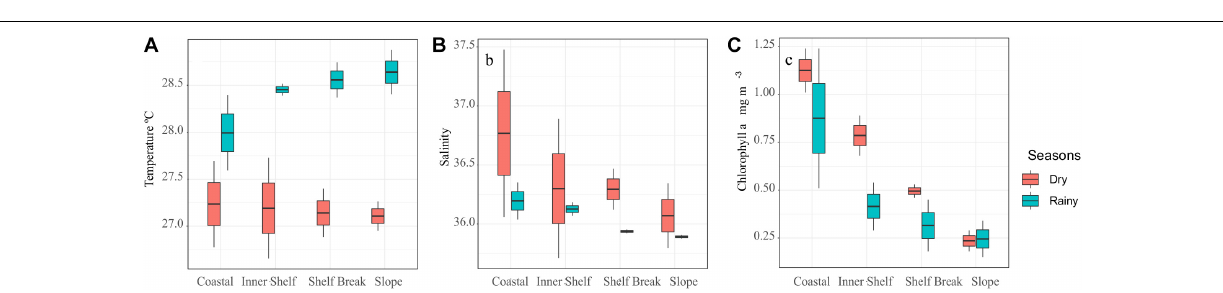
FIGURE 2 | Rainfall and air temperature from 2001 to 2004 at the coastal area of Rio Grande do Norte, Southwestern Atlantic (Source: http://www.inmet.gov.br).